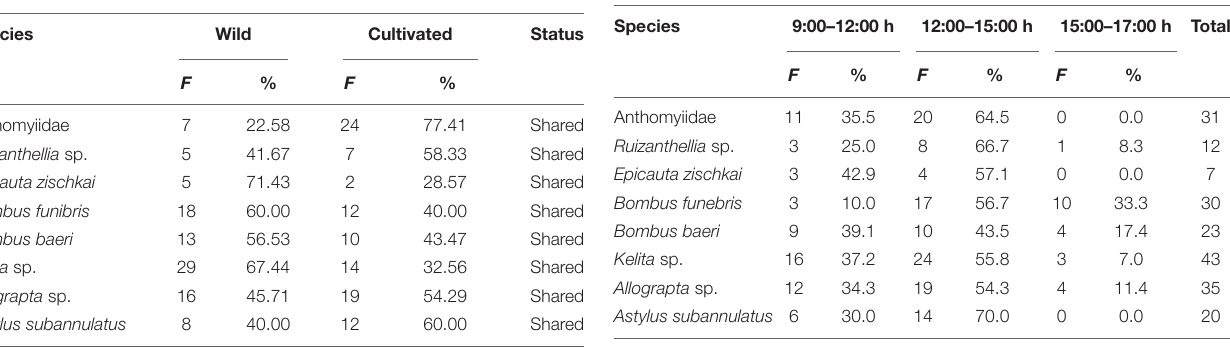
TABLE 8 | Periods of higher activity of insects visiting flowers of the potato species and varieties